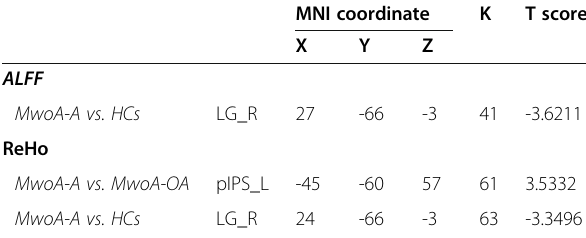
may provide new insights on the pathophysiology of Table 2 Regions showing differences in the ALFF and ReHo values among all groups MNI